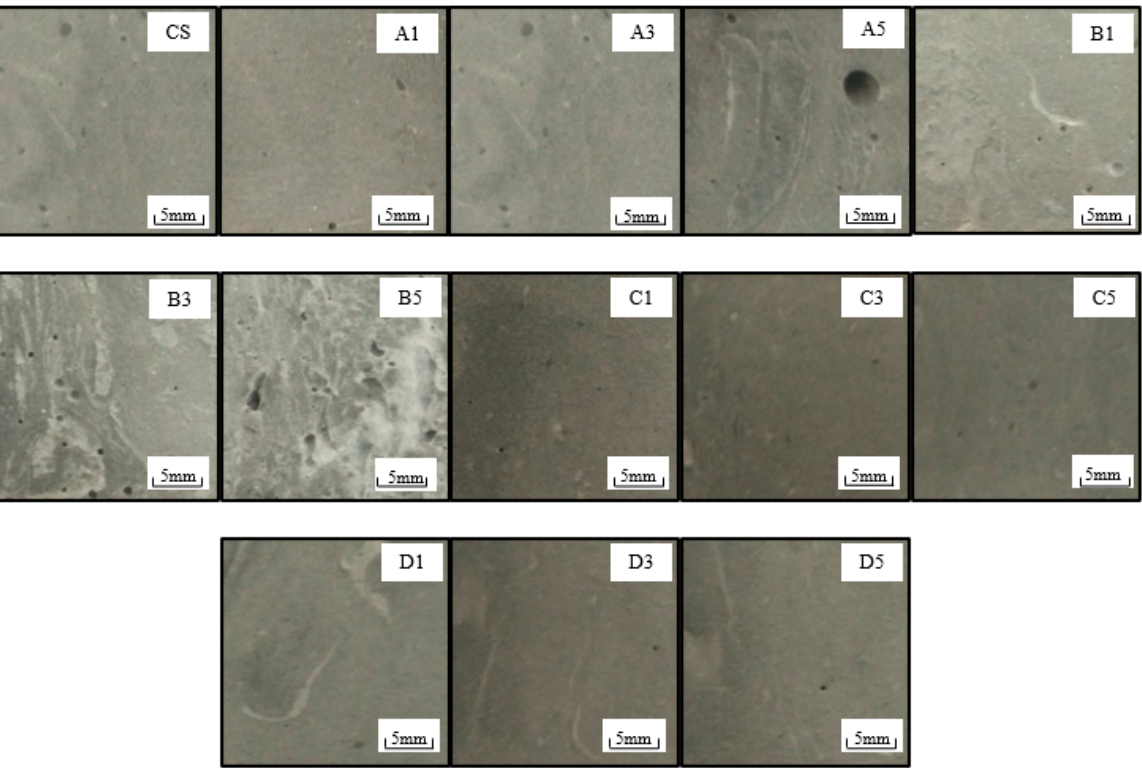
uncalculated NAC high-viscosity mineral is 23.07% and 40.62% higher than that of the cement without NAC. This indicated that an uncalculated high-viscosity mineral is not conducive to forming dense hardened cement. Adding calcined NAC can effectively reduce the porosity of hardened cement and improve the compactness, which is con- sistent with the conclusion in Figure 15. The porosity of hardened cement with 1%, 3%, and 5% NACis 19%, 19.04%, and 22.27% lower than that of the cement without NAC. When the content of NAC with high viscosity is 1%, 3%, and 5%, the porosity of hard- ened cement paste is 15.58%, 18.1%, and 21.46% lower than that of the cement without NAC, which indicates that calcined NAC raw ore has the best effect in improving the compactness of hardened cement paste. The effect is the best when the content is 5%.